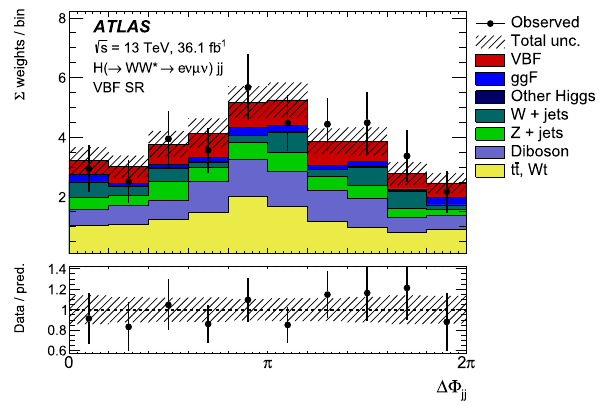
Fig. 7 The weighted (cid:10)(cid:11) jj distribution in the VBF signal region, with signal and background yields fixed from the fit for ε VV using shape and rate information. Data-to-simulation ratios are shown at the bottom of the plot. The shaded areas depict the total uncertainty and background control regions defined in Tables 3 and